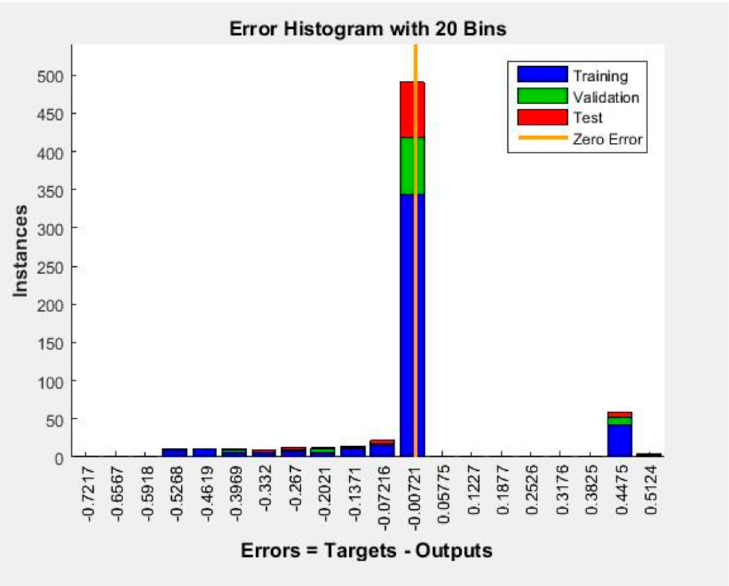
Figure 13. Histogram of errors made by the network using second-degree polynomial coefficients.